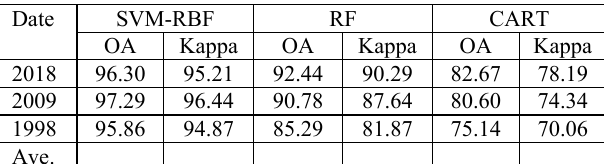
Table 7. Classification and accuracy assessment of Bihar